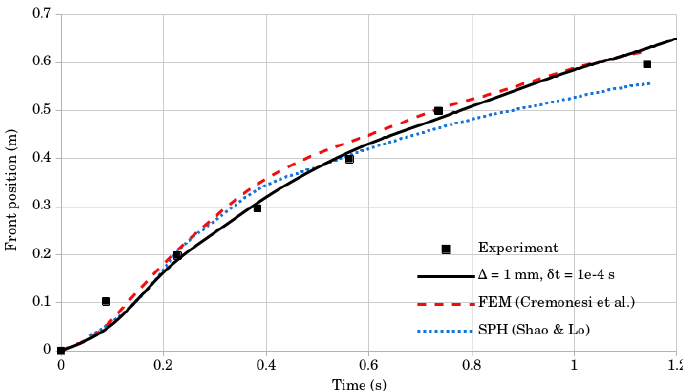
Figure 8. Mass front position results; numerical simulations compared to the experimental data.